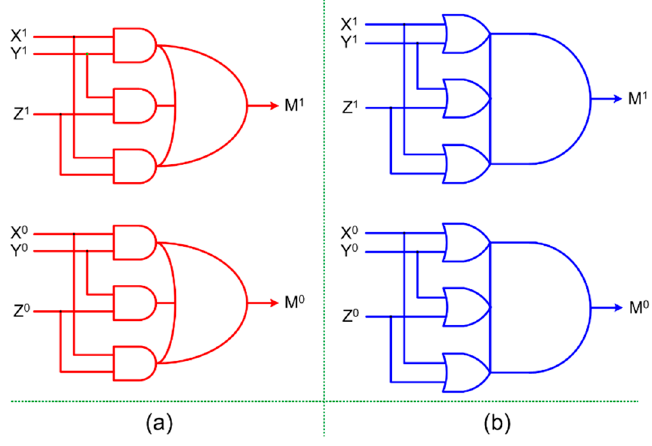
Figure 4. Proposed early output majority voter corresponding to: ( a ) RTZH; ( b ) RTOH. The proposed early output majority voter is a monotonic Boolean network (MBN)